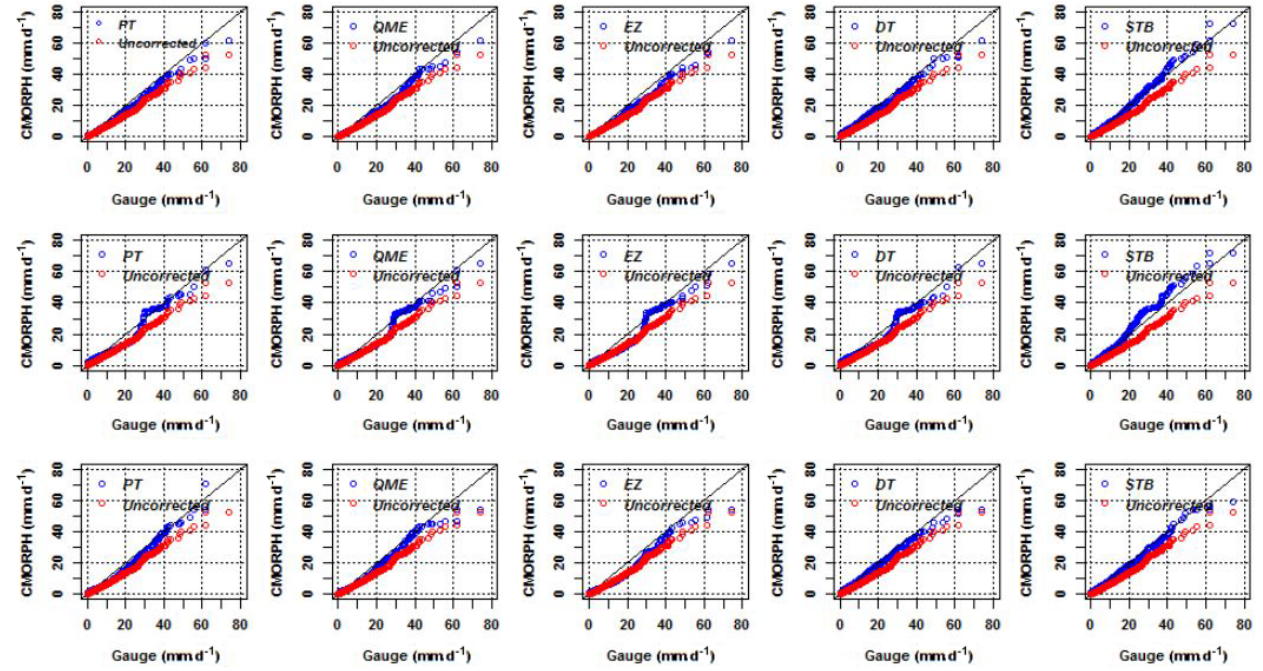
Figure 7. q – q plot for gauge vs. satellite rainfall (uncorrected and bias corrected) for the Upper (top panels), Middle (middle panes), and Lower (bottom panels) Zambezi. Table 5. Temporal cross-validation results for the period 1998–1999 for the wet and dry